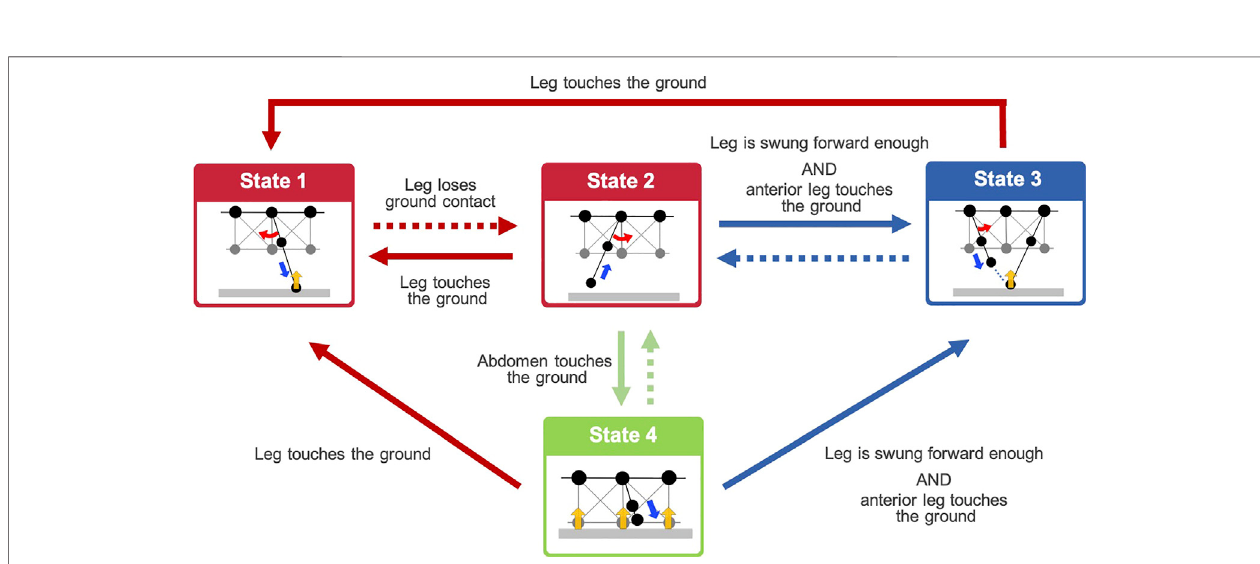
FIGURE 3 | Overview diagram of the behavioral transitions based on the proposed decentralized leg control rules. Dashed arrows denote the negation of conditionsrepresentedbythesamecoloredarrows.States1 – 4denotetheactionexecutedbyRules1 – 4,respectively.Detailsoftheactionineachstateareillustratedin Figure 4